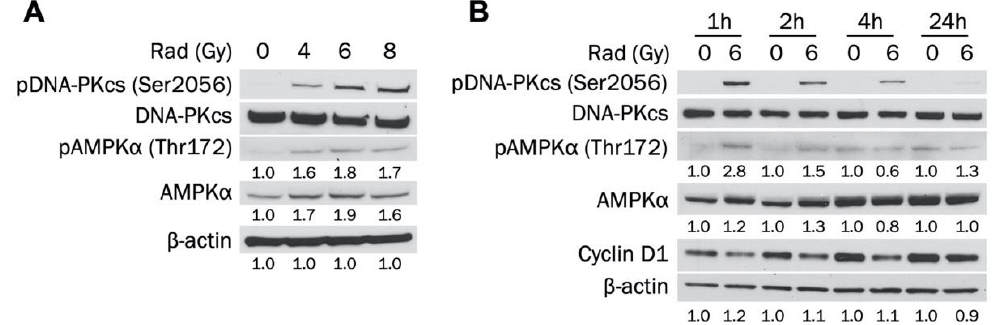
Figure 4. Radiation increases levels of activated and total AMPKα in MDA -MB-231 cells. ( A ) MDA- MB-231 cells were exposed to 0, 2, 4, or 6 Gy radiation dose and collected 1 h after irradiation. Total and phosphorylated AMPKα and DNA -PKcs expression levels were determined by Western blot. ( B ) MDA-MB-231 cells were exposed to 0 or 6 Gy radiation dose and collected 1 h, 2 h, 4 h, or 24 h after irradiation. Total and phosphorylated AMPKα and DNA -PKcs expression levels were determined by Western